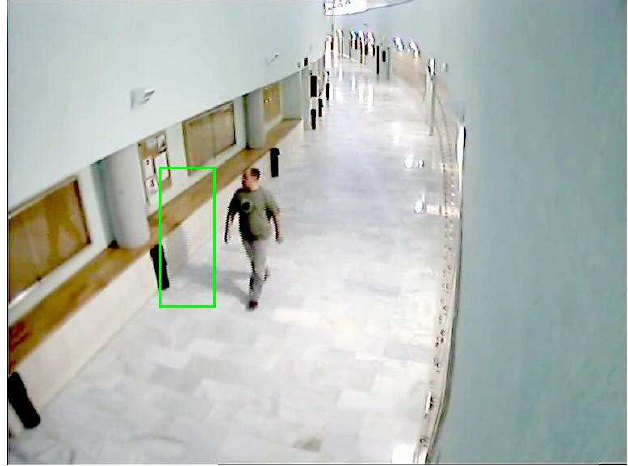
Figure 5. Example of the error activity. Bounding box (in green) does not contain the